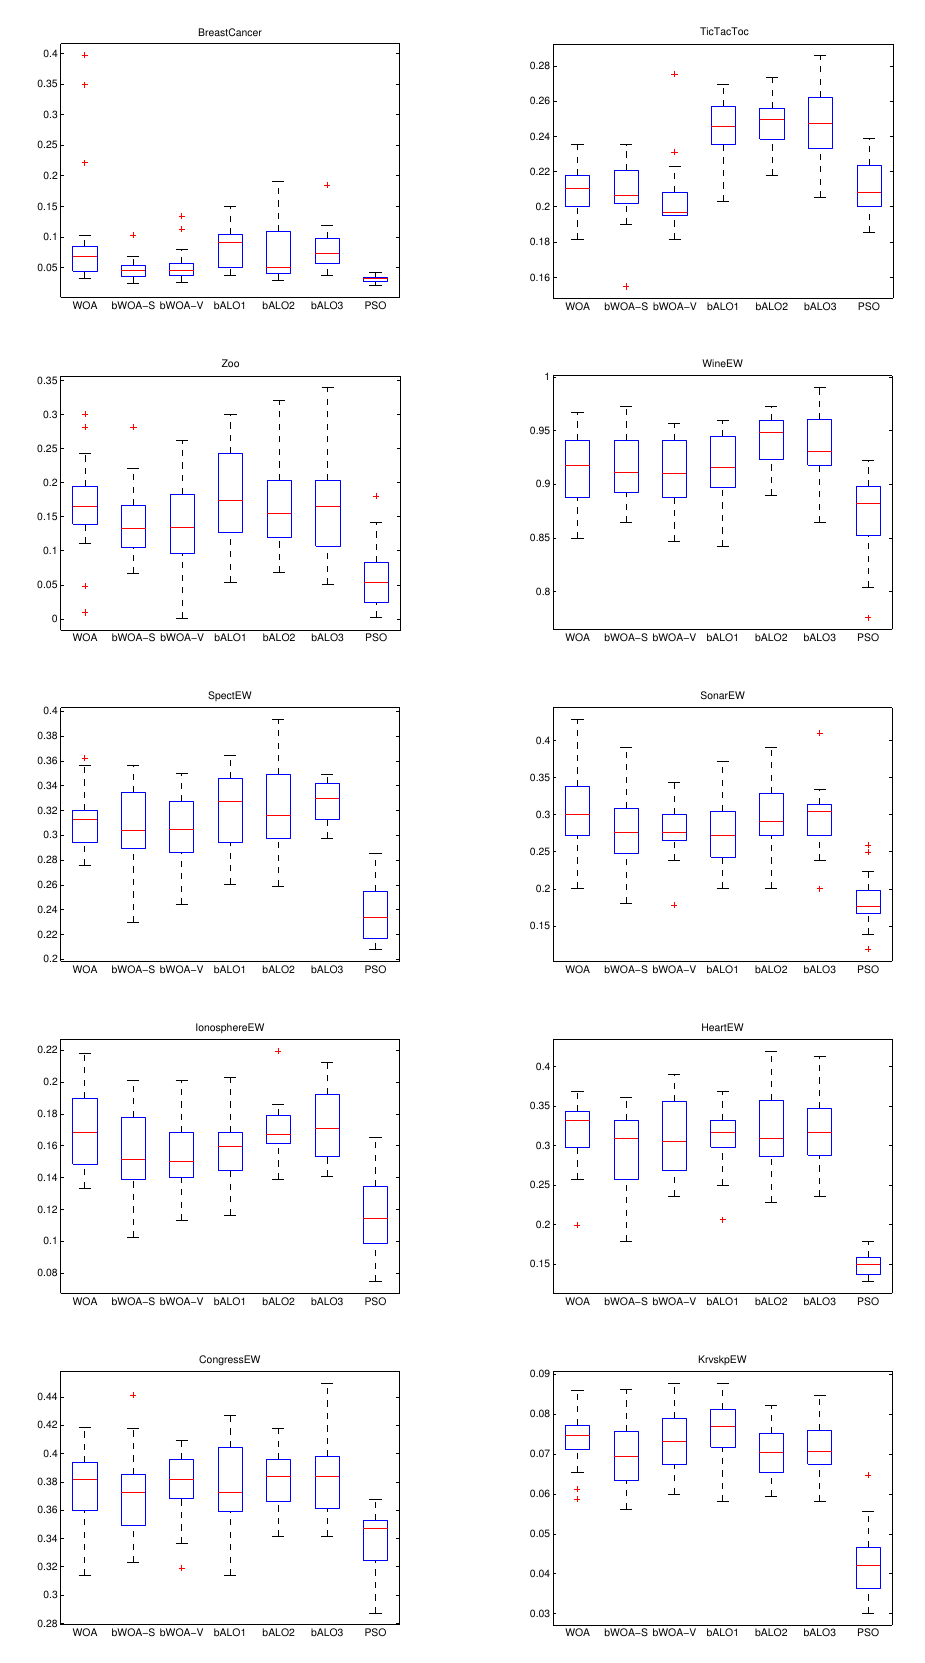
Figure 7. Mixed initialization boxplot for the compared algorithms on the different